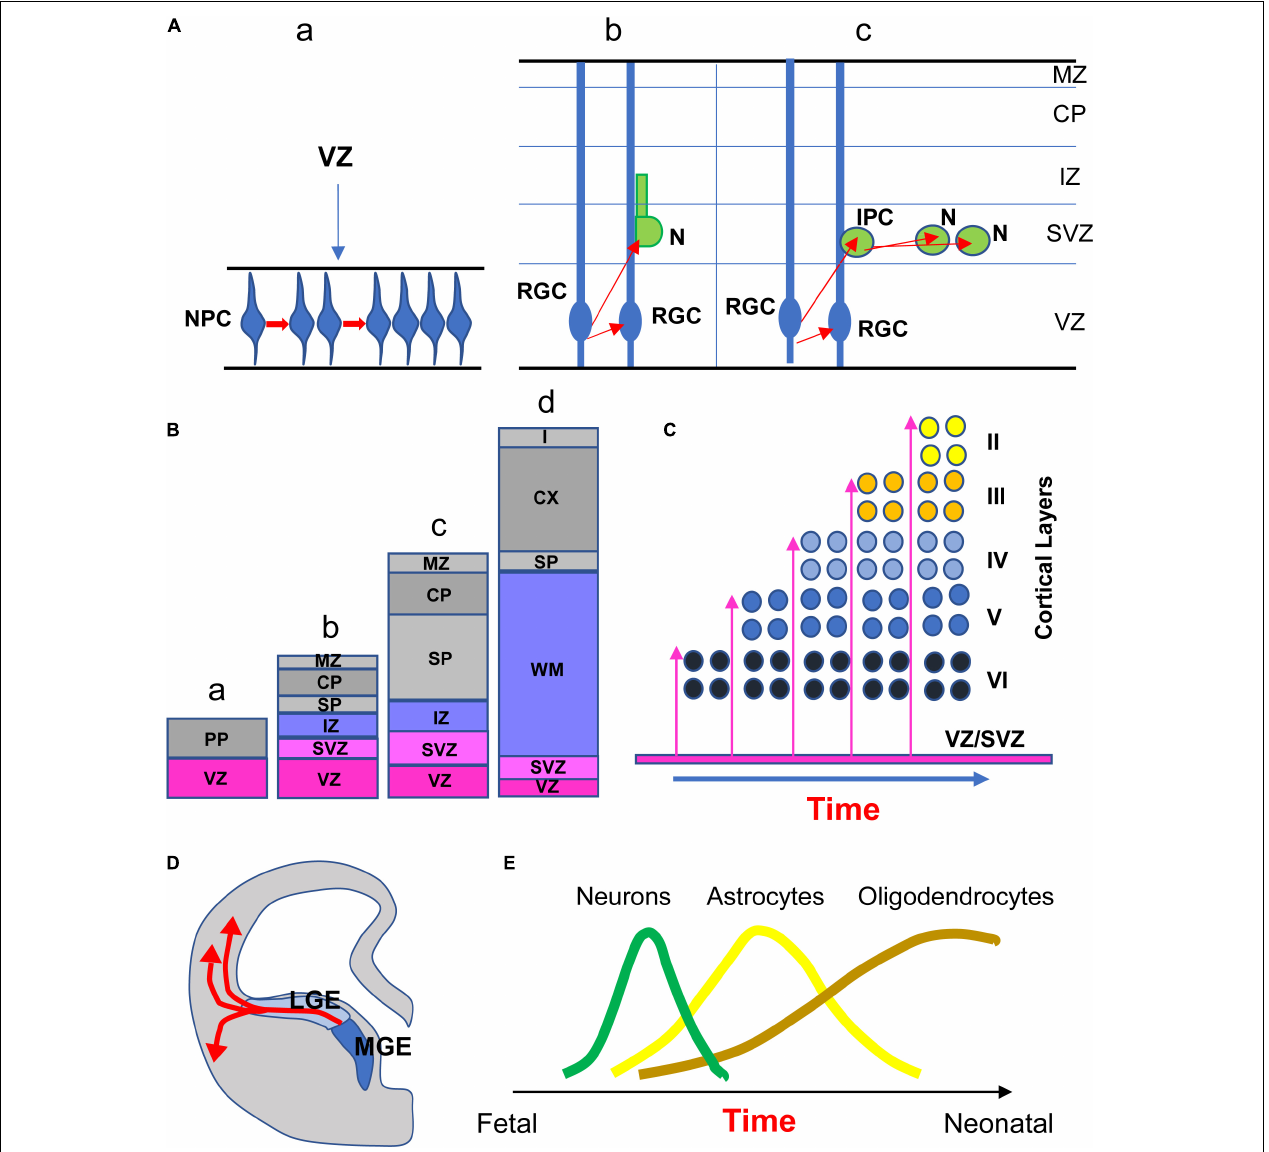
FIGURE 1 | (A) The first step of neurogenesis increases the size of the pool of the neural progenitor cell (NPC) population through symmetrical cell divisions (a). NPCs, that begin as neuroepithelial cells, then become radial glia cells (RGC). Beginning at ∼ E42, asymmetrical divisions of RGC produce one RGC that remains proliferative and one neuron (N). The postmitotic neuron leaves the proliferative zone migrating along radial glia processes to reach its place in the developing cortex (b). Asymmetric divisions of RGC can produce one RGC that remains proliferative and one intermediate progenitor cell (IPC; also called transit amplifying cell) that undergoes divisions (c). (B) Development of laminar compartments in the neocortical cerebral wall from early embryonic (a) to late fetal period (d). Neurons migrate radially from the VZ out to the developing cortex. The first neurons leaving the VZ form the preplate (PP; a). Further waves of neuron migration split the PP into the marginal zone (MZ) and the subplate (SP), giving origin to a new region called the cortical plate (CP; b, c) which will give origin to the future cortex (d). The CP is separated from the SVZ by the intermediate zone (IZ), that will later become the white matter layer (d). (C) The earliest neurons migrating to the cortical plate settle to what will become layer VI. Successively migrating neurons settle to progressively more superficial cortical layers (inside-out pattern). (D) Interneurons born in the ganglionic eminences reach their destination through tangential migration. (E) Relative timing of neurogenesis, astrogliogenesis, and oligogliogenesis during brain development in humans, schematically depicted based on evidence in rodents. Abbreviations: CP, cortical plate; IPC, intermediate progenitor cell; IZ, intermediate zone; LGE, lateral ganglionic eminence; MGE, medial ganglionic eminence; MZ, marginal zone; N, neuron; NPC, neural progenitor cells; PP, preplate; RGC, radial glial cells; SP, subplate; SVZ, subventricular zone; VZ, ventricular zone; and WM, white